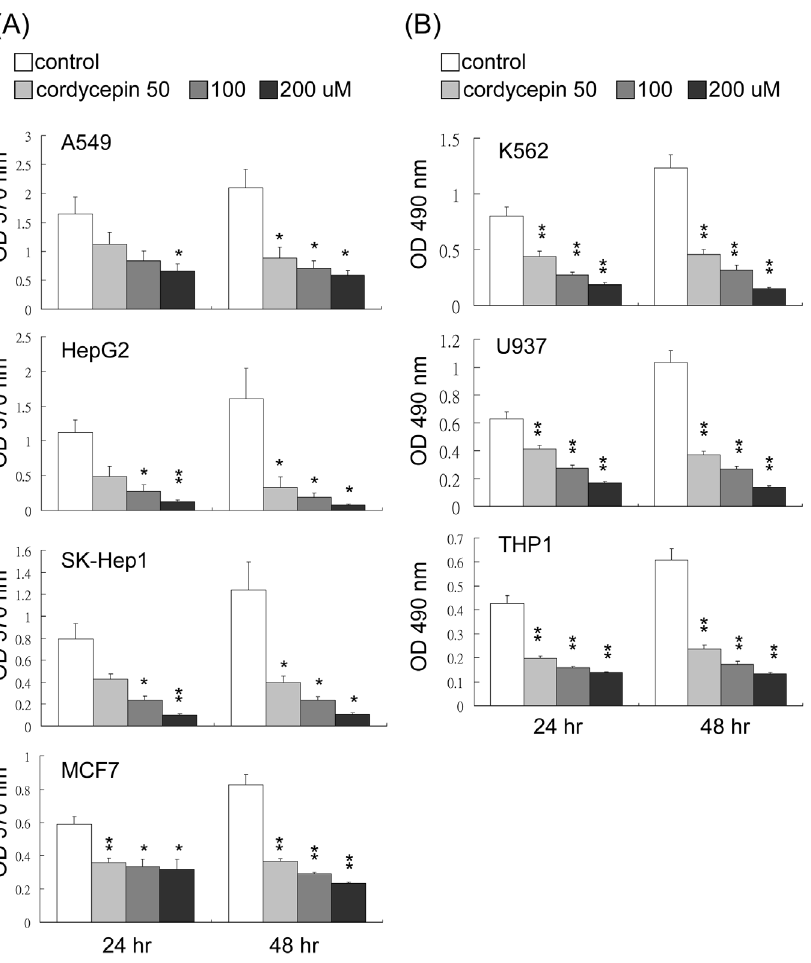
Figure 1. Cordycepin suppresses cell proliferation in various cancer cells. (A) A549, HepG2, SK-Hep1 and MCF7 cells were treated with cordycepin at 50–200 m M for 24 hrs and 48 hrs and cell proliferation was determined by an MTT assay. (B) U937, K562 and THP1 cells were treated with cordycepin at 50–200 m M for 24 hrs and 48 hrs and cell proliferation was determined by an MTS assay. These data are from three independent experiments. Each bar denotes mean 6 S.E.M. *, P , 0.05, **, P , 0.01.